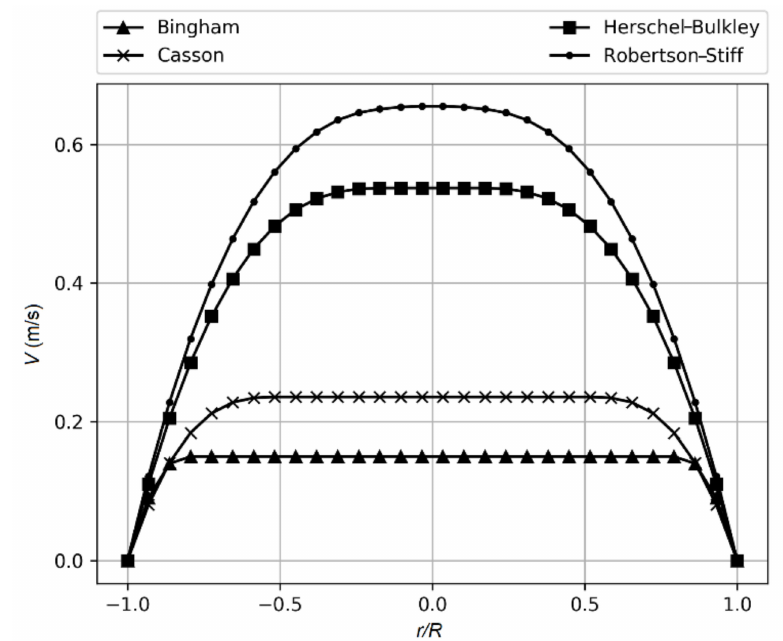
Figure 9. Axial laminar velocity profiles that were calculated based on different rheological